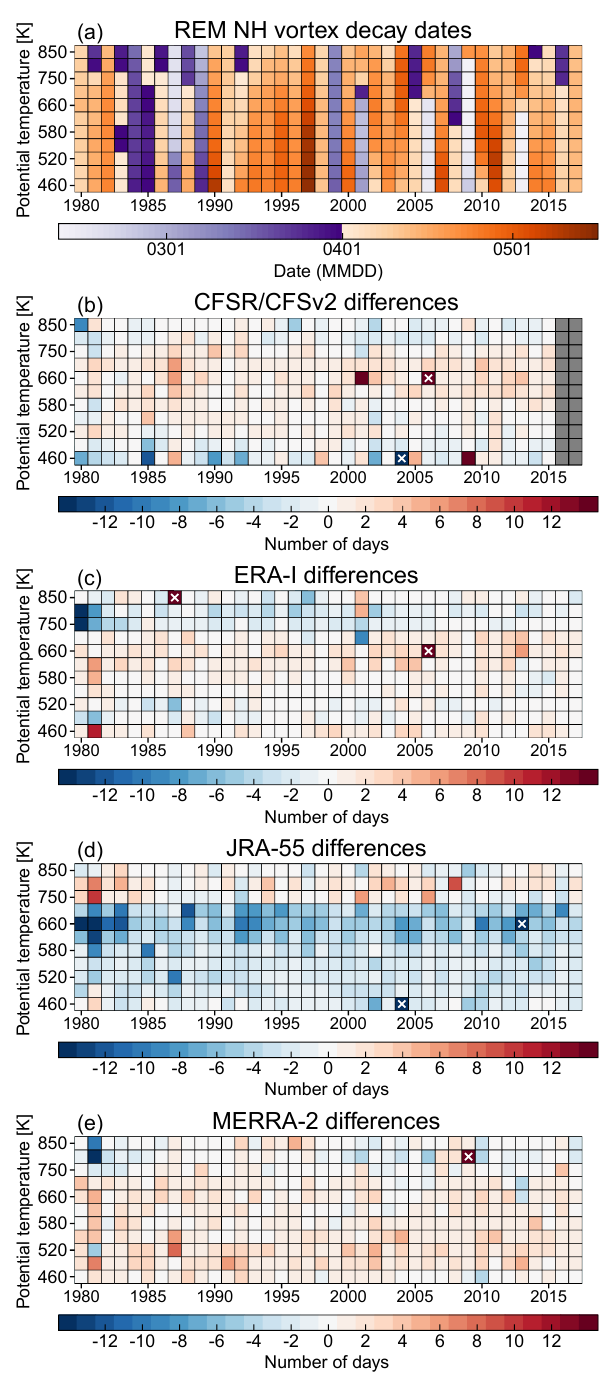
Figure 18. As in Fig. 17 but for the NH. The color bar ranges are restricted to distinguish differences of a few days; differences whose magnitude greatly exceeds the range (by more than 7 days and thus differences with magnitude greater than 21 days) are marked with a white X